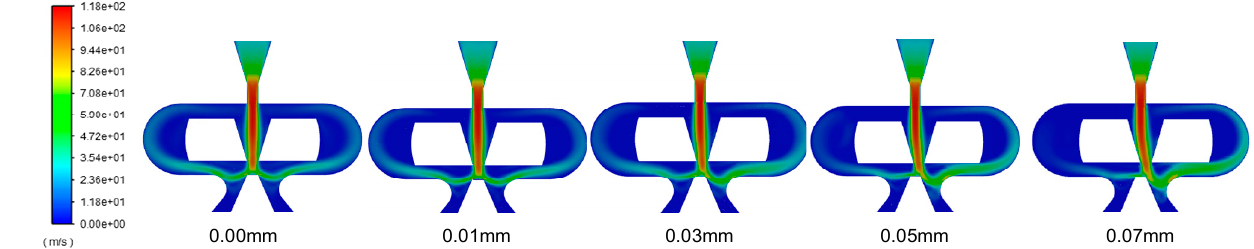
Figure 8. The velocity under different deflector displacement.